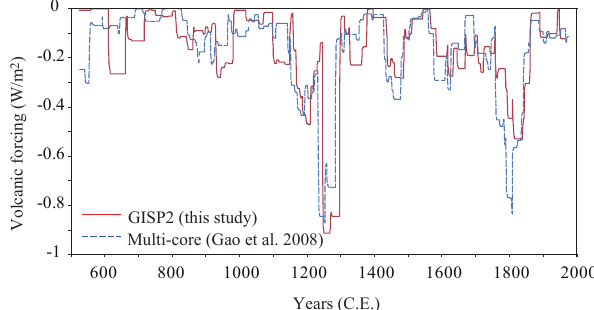
Fig. A1. Reconstructed volcanic forcing over the past 1500yr on the multidecadal timescale. Red and blue lines represent volcanic forcing reconstructions from a single core (GISP2, this study) and multi-cores (Gao et al., 2008). 51yr RMs were applied for both data to reduce